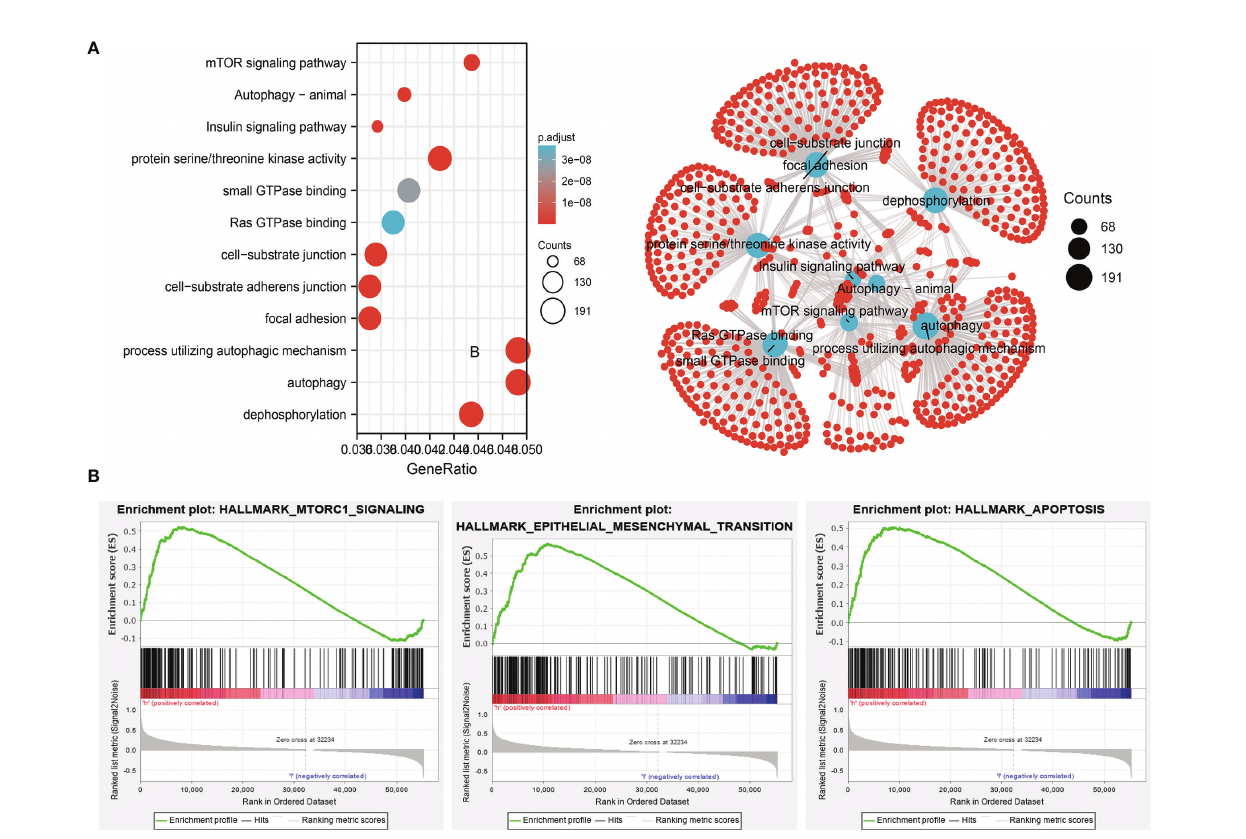
FIGURE 3 | Analysis of the biological function for miRNA-195-5p downstream target genes in human cancers. (A) The KEGG signaling pathway of miRNA-195- 5p downstream target genes in lung-cancer analysis by the starbase. (B) The hallmark of miRNA-195-5p downstream target genes in lung cancer analysis by the GSEA